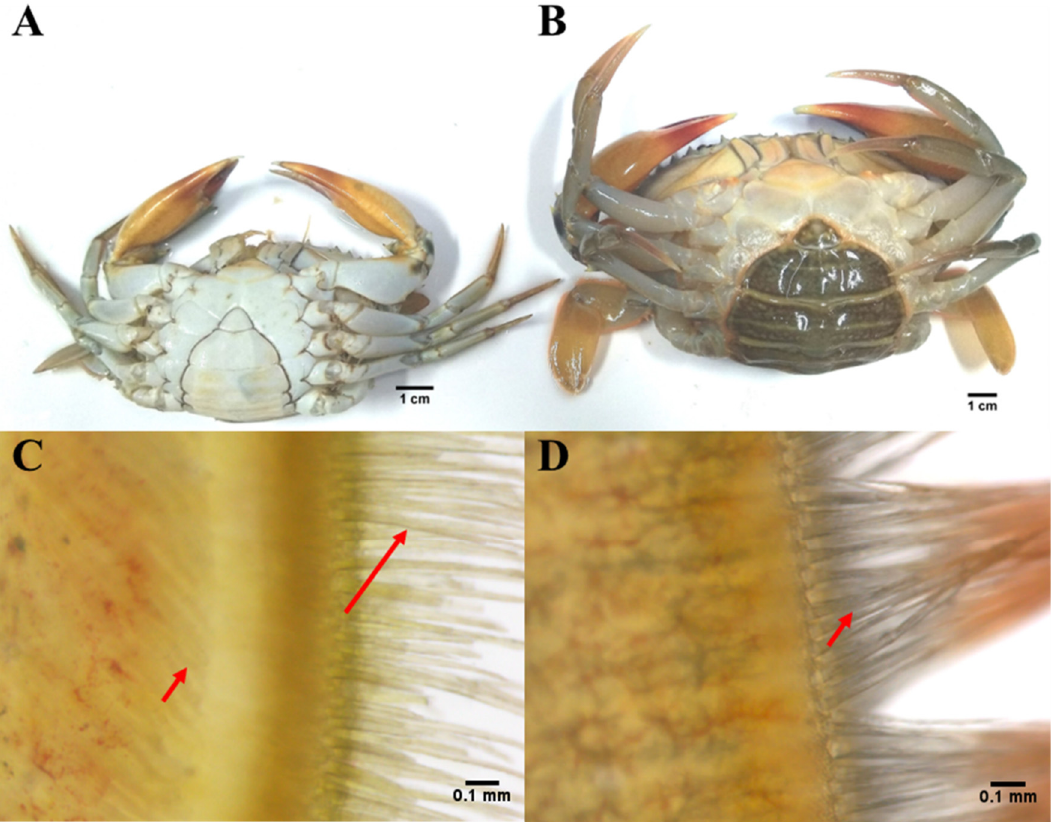
Figure 7. Experiment animals ( S. paramamosain ) in ( A , C ) pre- and ( B , D ) post-pubertal molt groups. ( A ) Crabs in pre-pubertal molt stage. ( B ) Crabs in post-pubertal molt stage. ( C ) Cuticle structure in swimming leg in pre-pubertal molt stage; long arrow, old setae; short arrow, new setae. ( D ) Cuticle structure in swimming leg in post-pubertal molt stage; short arrow, new setae.